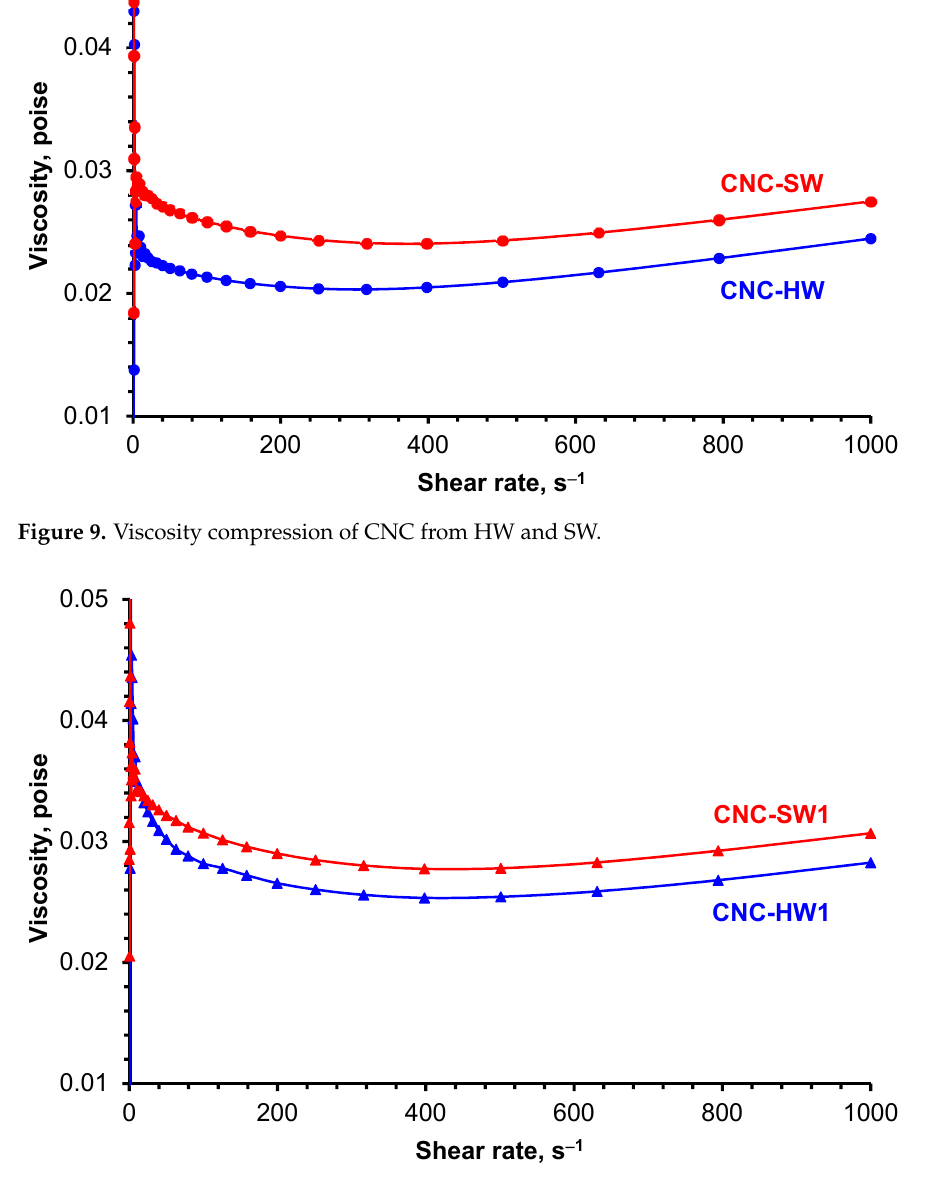
Figure 10. Viscosity comparison of CNC from oxidized HW1 and oxidized SW1.